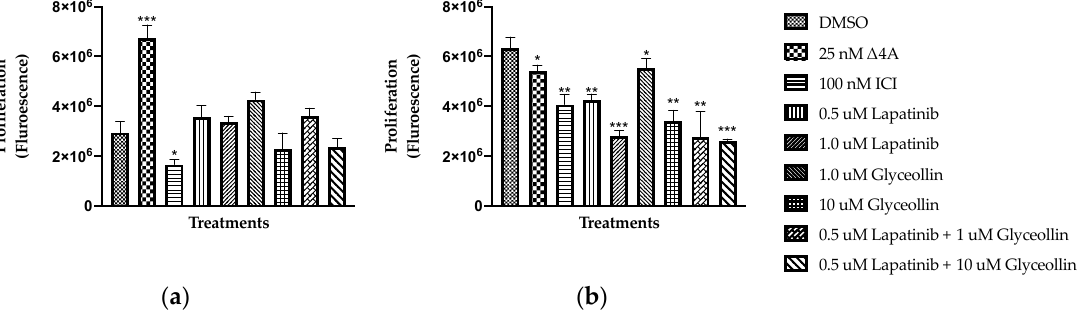
Figure 3. Letrozole ‐ resistant cells are more sensitive to the growth inhibitory effects of glyceollin and/or lapatinib. ( a ) The T47Darom cells were cultured in standard growth media and transferred to phenol red free media for two days prior to treatment with DMSO vehicle control, 25 nM andros ‐ tenedione, 100 nM ICI, 0.5 μ M or 1.0 μ M lapatinib, 1 μ M or 10 μ M glyceollin, 0.5 μ M lapatinib ± 1 μ M glyceollin or 10 μ M glyceollin, and cell proliferation assays were performed after 5 days. ( b ) The T47DaromLR were withdrawn from letrozole for 7 days prior to treatment and treated as indi ‐ cated above. Proliferation was measured using the resazurin assay, and graphs depict the fluores ‐ cence intensity of cells read at 430/560 nM wavelengths over the course of 5 days. Student’s t ‐ tests were performed, and treatments were compared to the DMSO control. Results are expressed as the mean unit ± SD (*** p < 0.001, ** p < 0.01, * p < 0.05) of three independent experiments in triplicate.